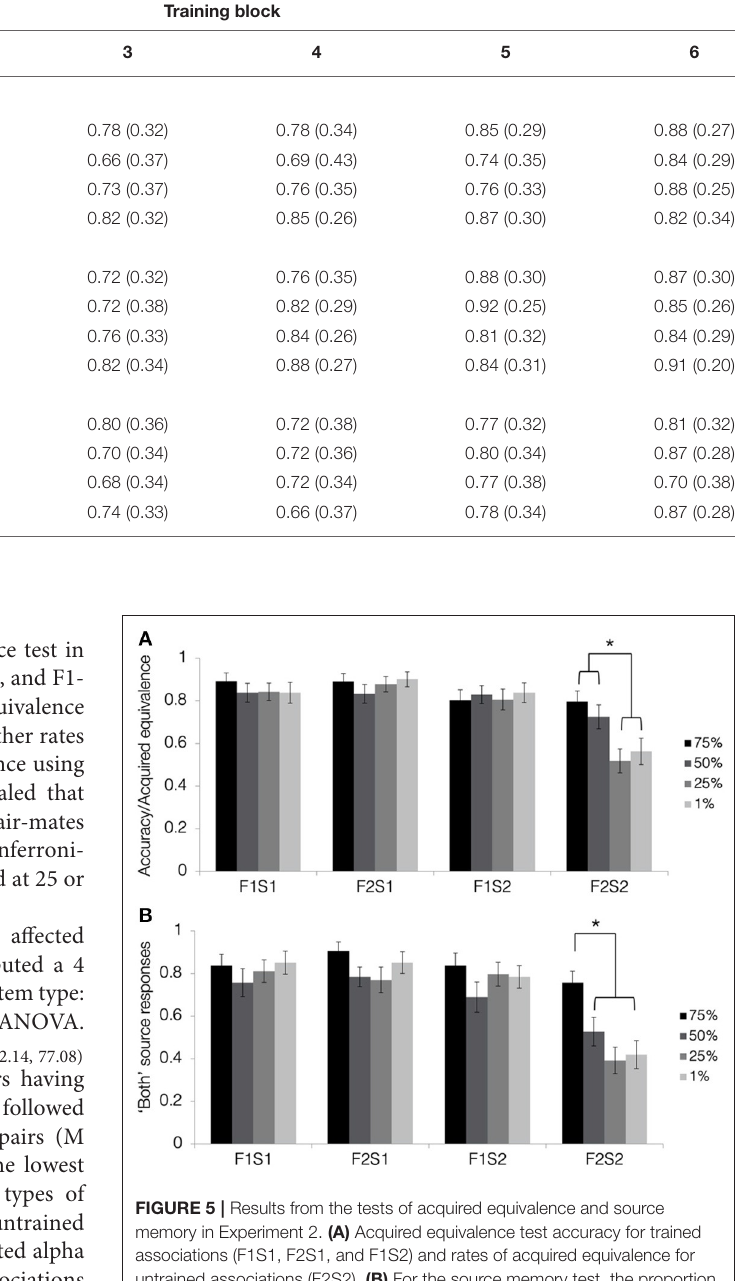
TABLE 2 | Experiment 2 training accuracy separated by block, shared parent blend level, and trained association type. Experiment 2